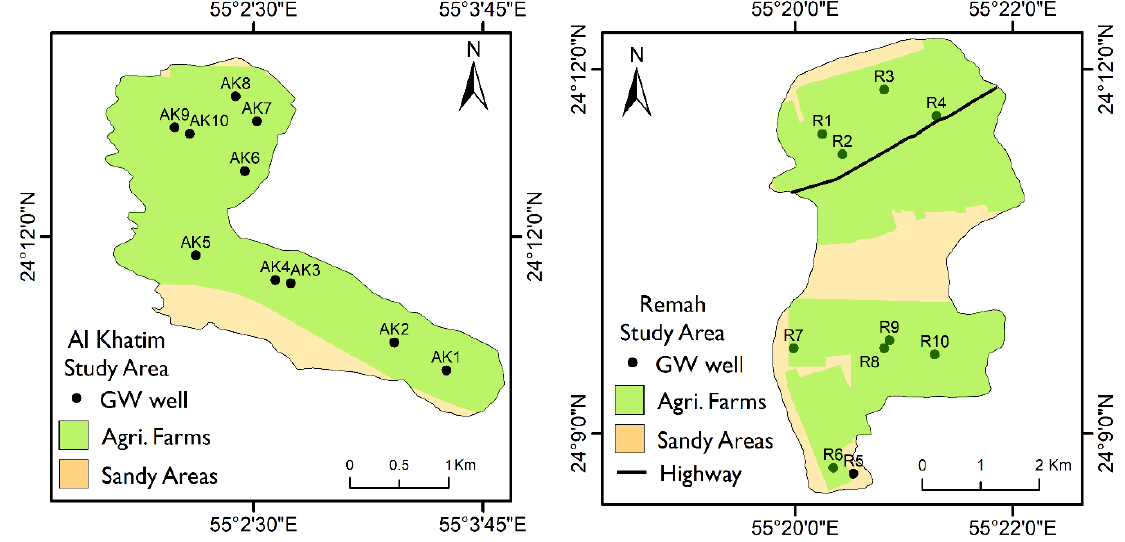
Figure 5. Sampled groundwater wells and land use map for Al Khatim and Remah study areas.